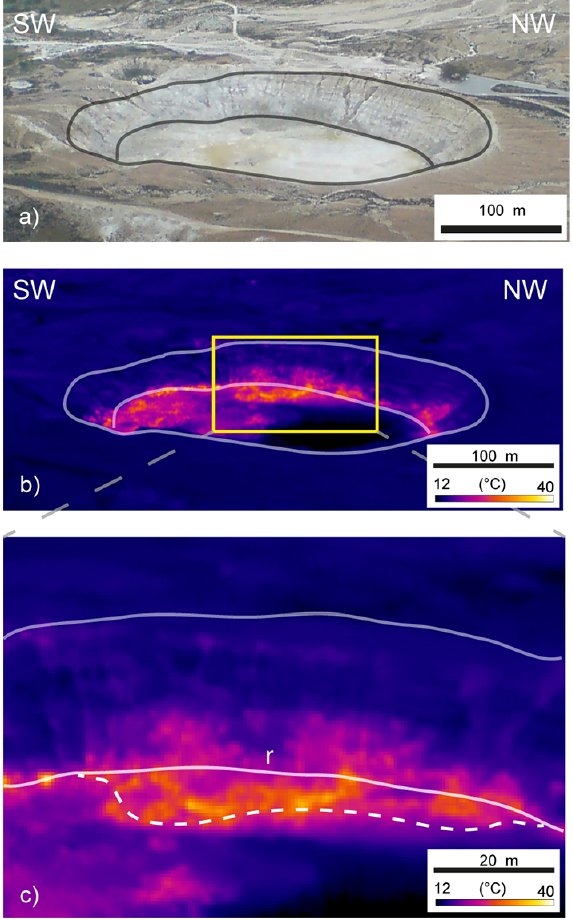
Fig. 2. (a, b) OP and IR images collected from long distance (caldera rim, Fig. 1b). Solid lines mark the upper and lower crater rim. Both the OP and IR images display part of the crater floor and the east-facing flank; the IR images show thermal anomalies along the bottom rim and a weaker anomaly toward the center of the crater but also propagating to the south. The yellow rectangle in (b) de- fines the area shown by the close-up in (c) . (c) Magnification of the wide thermal anomaly (r, dashed line) on the western side of the crater. The coarse spatial resolution ( ∼ 0.8m) causes the smoothed appearance of the temperatures.